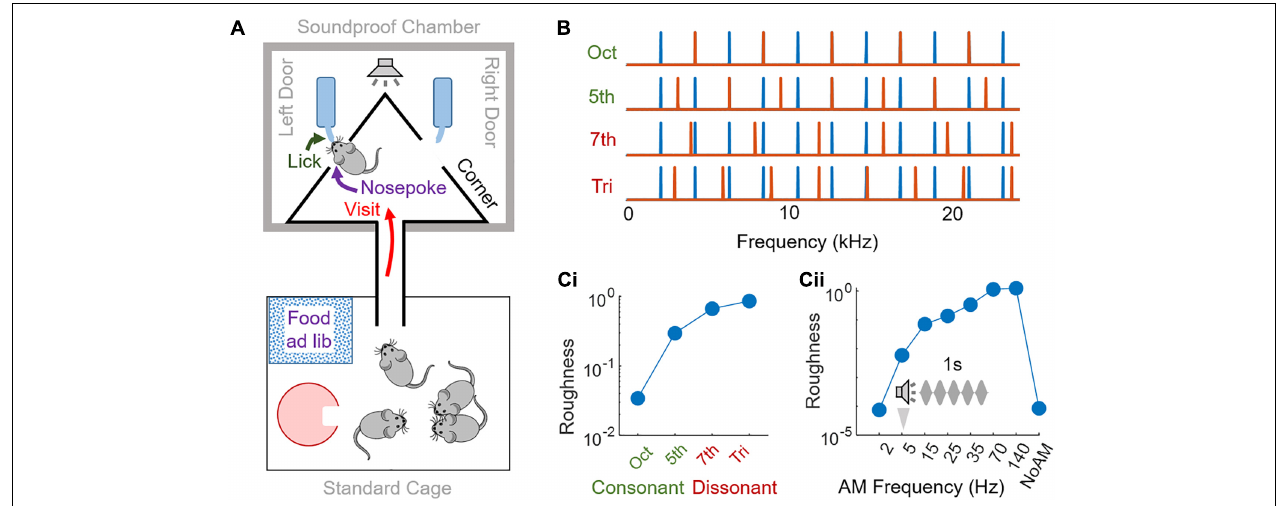
FIGURE 1 | Experimental design. (A) Schematic of the Audiobox. The mice were kept in groups of 4–5 animals. A standard cage enriched with igloos served as the home cage, with food ad libitum , and was connected to a soundproof chamber through a corridor. The soundproof chamber contained the “corner,” the apparatus monitoring mouse behavior and controlling their access to water. A “visit” was registered when an antenna located at the entrance of the experimental corner read a transponder implanted in each mouse and a heat sensor was simultaneously activated. The mouse could then do a “nosepoke” into one of the two doors inside the corner and access water (“lick”). The stimulus was presented, through a speaker positioned 30 cm above the corner, either when a mouse visited or nosepoked, depending on the protocol, and according to the specific mouse that had been identified. (B) Spectrum of consonant and dissonant chords used. Frequency components of the first reference harmonic complex tone (blue) and the second tone (orange) were in ratios of (from top to bottom): 2 (octave, consonant), 3/2 (perfect fifth, consonant), 15/8 (major seventh, dissonant) or 45/32 (augmented fourth or tritone, dissonant). (Ci,ii) Roughness measure estimated thanks to (Vassilakis, 2001) for: (Ci) consonant and dissonant chords; (Cii) amplitude modulated reference harmonic complex